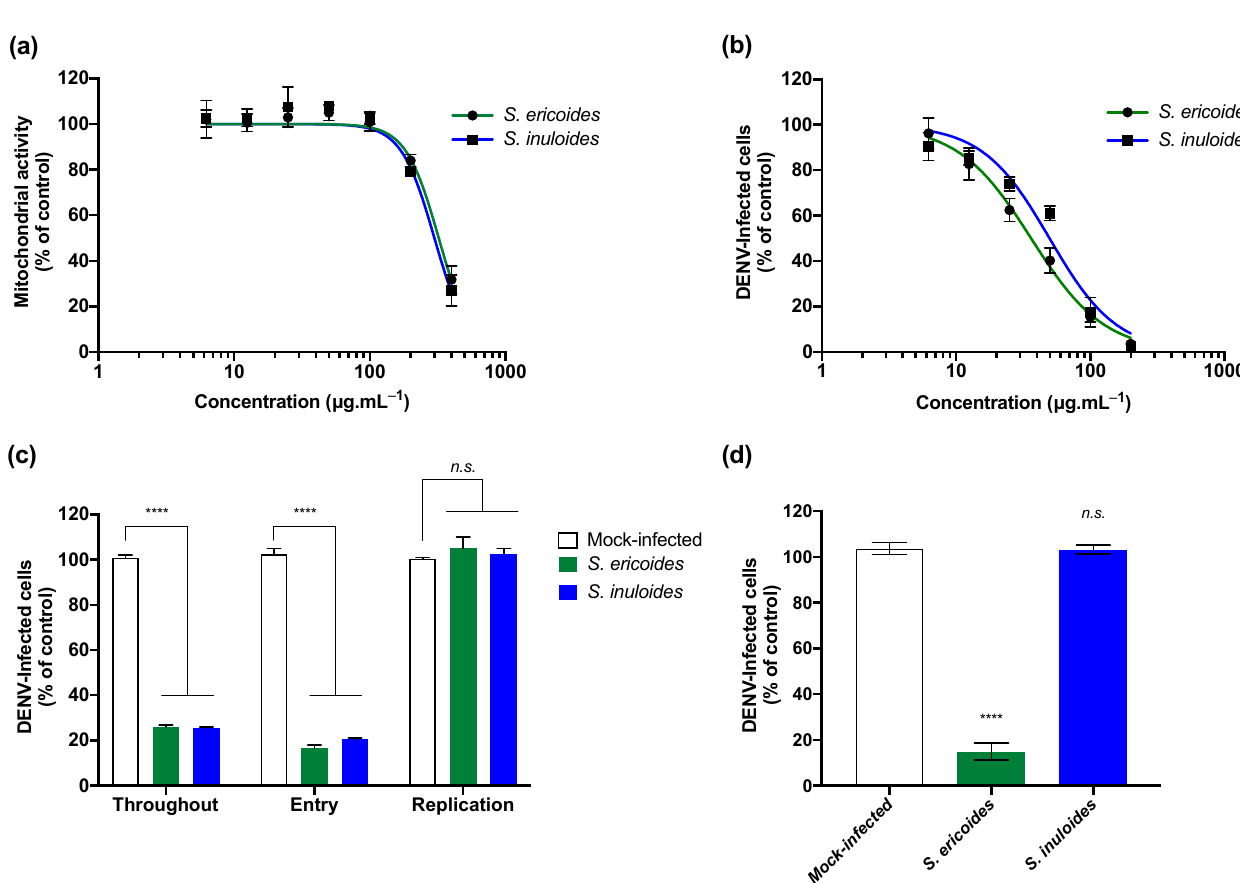
Figure 4. S. ericoides and S. inuloides extracts exhibit antiviral activity against the clinical isolate of DENV-2 at non cytotoxic concentrations. ( a ) Huh7.5 cells were incubated with various concentrations of Stenocline extracts (400–6.25 µg.mL − 1 ) for 48 h. Using the MTT assay, mitochondrial activity was assessed. ( b ) Huh7.5 cells were infected with DENV-2 at an MOI of 1 and treated simultaneously with different concentrations (200–6.25 µg.mL − 1 ) of plant extracts for 48 h. The percentage of Huh7.5-infected cells was determined by flow cytometry using the anti-flavivirus E mAb 4G2. ( c ) Flow cytometric analysis of E-expression in Huh7.5 cells infected during 48 h with DENV-2 at an MOI of 1 at different time of addition of Stenocline extracts (100 µg.mL − 1 ). ( d ) Huh7.5 cells were infected with DENV-2 pre-incubated during 1 h at 37 °C with 100 µg.mL − 1 of Stenocline extracts. Flow cytometric analysis of E-positive cells was performed 48 hpi. Data represent the means ± SD of three independent experiments performed in triplicate and are expressed as relative values compared to mock-treated control. **** p < 0.0001; n.s. = not significant